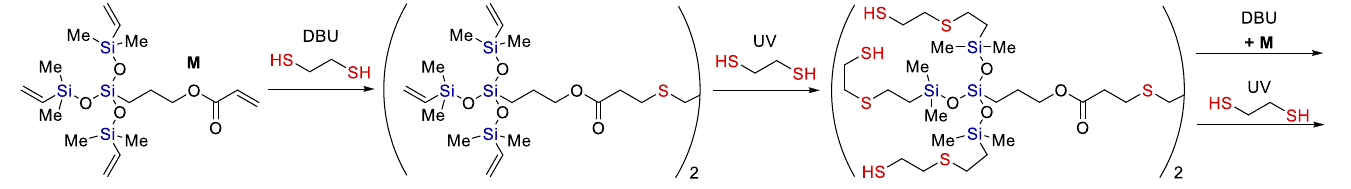
Figure 3. A scheme of the synthesis of carbosilane dendrimers by sequential Michael thiol-ene addition and radical thiol-ene addition reactions. Adopted from Ref.